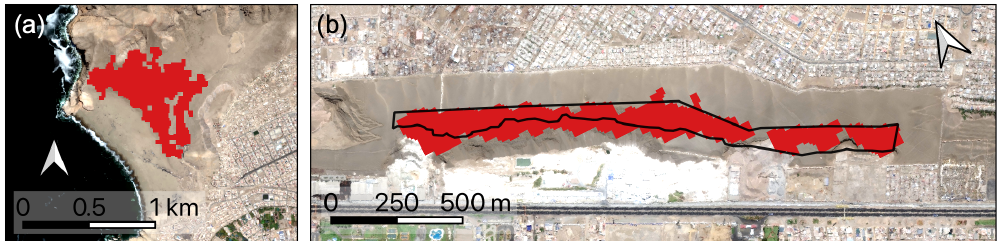
Figure 3. Sentinel-1 SAR-based map of the recent informal settlement in the Morro Solar (a) and Lomo de Corvina (b) . Basemaps: MAXAR